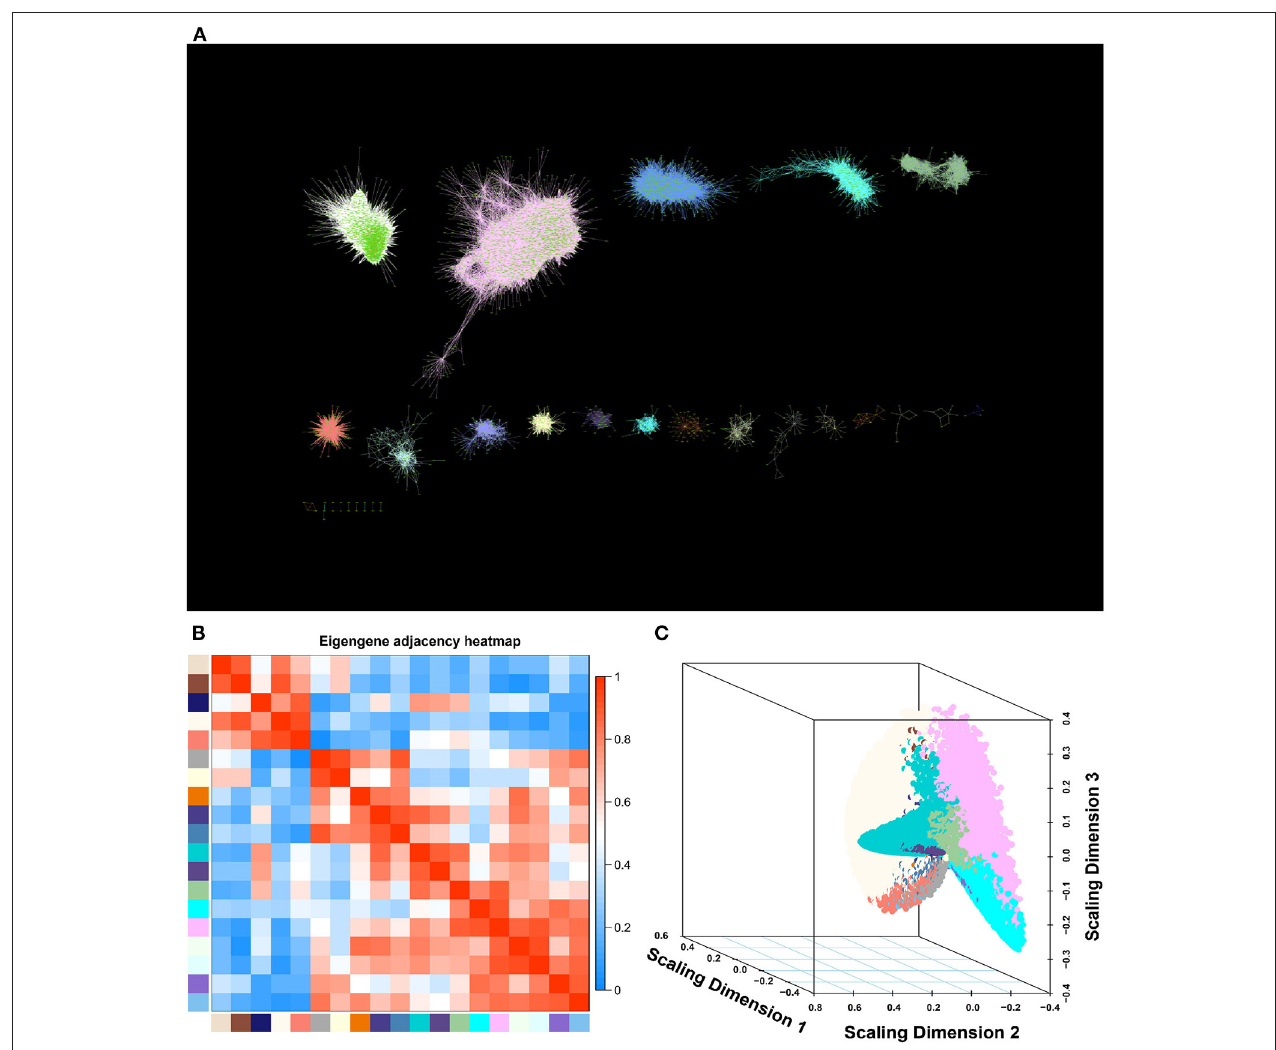
FIGURE 1 | A global gene co-expression network related to hypocotyl length in soybean. (A) Global gene co-expression network including 19 modules visualized with Cytoscape. (B) Eigengene adjacency heatmap of 19 modules. Each row/column corresponds to a module. Each cell contains a corresponding correlation indicated by color. (C) Multidimensional scaling plots of the TOM-based dissimilarity of gene expression in different